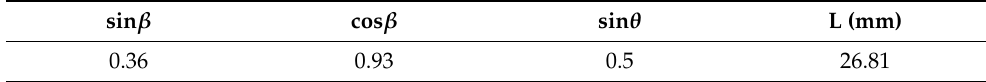
Table 1. Parameters of the chiral